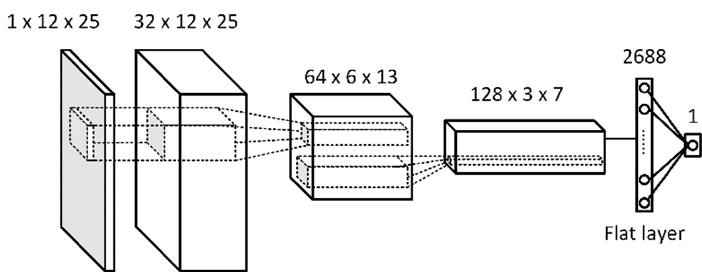
Figure 9. Generator G of the Unrolled GAN used in the study.